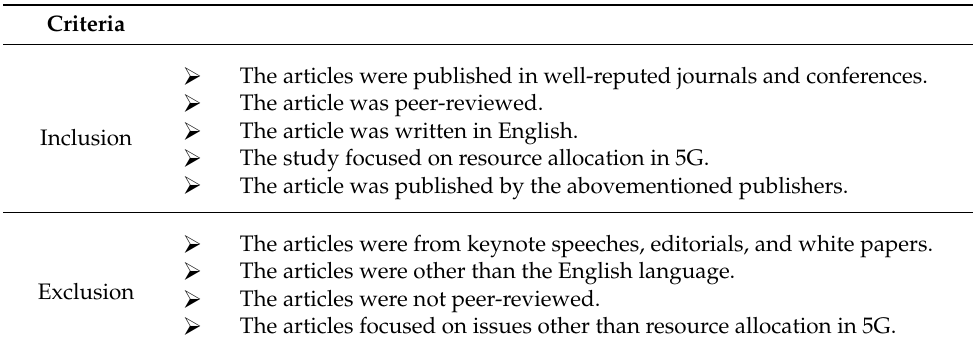
Table 3. Inclusion and exclusion criteria.